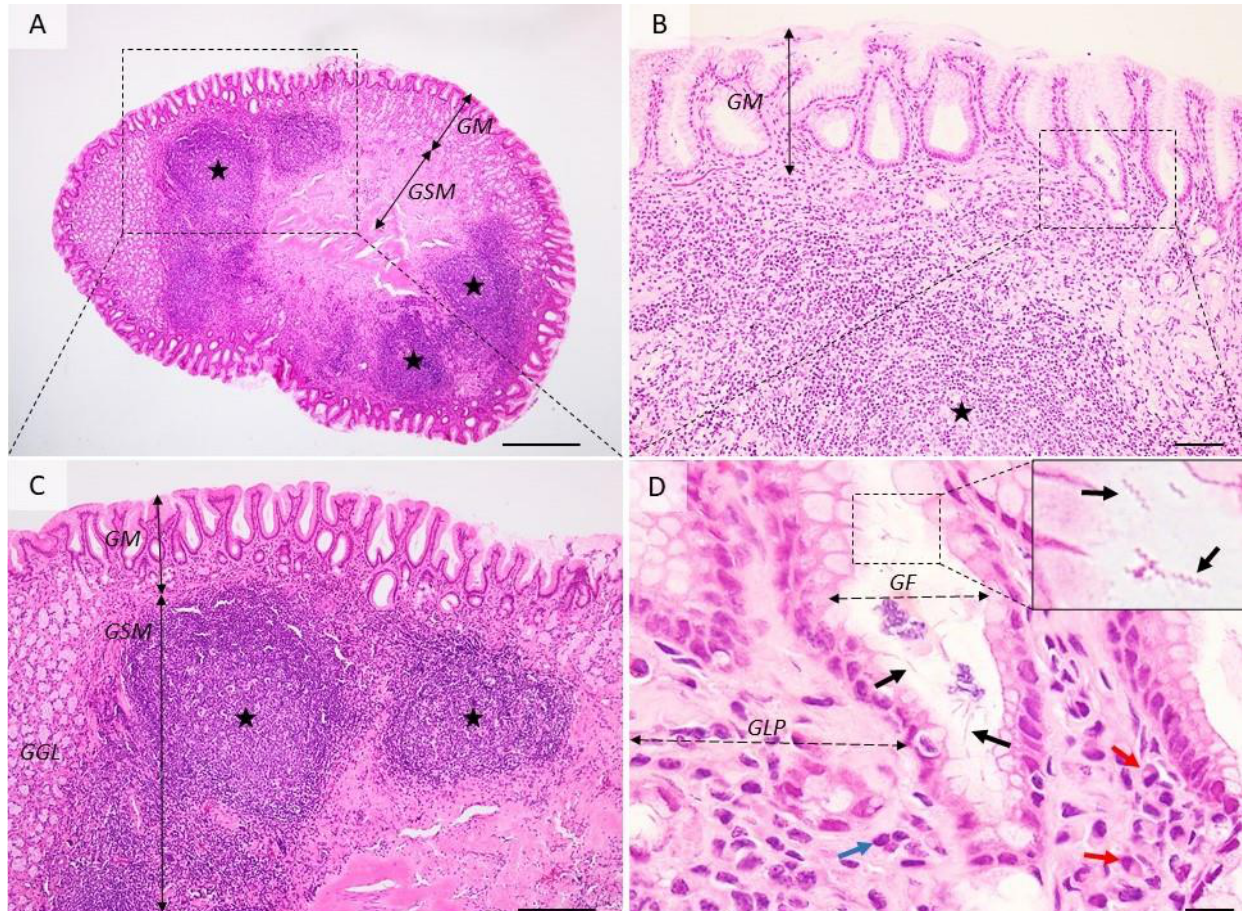
Figure 2. Histological aspects of follicular gastritis. ( A – C ) The lamina propria is multifocally distended and the gastric glands are displaced by many coalescing lymphoid follicles showing normal lymphocyte maturation. ( D ) Detailed demarcated area from ( B ). Within the gastric pits and superficial epithelium, there are many extracellular spiral-shaped bacteria measuring up to 7 µm. The lamina propria is infiltrated by many plasma cells (red arrow) and lymphocytes (blue arrow). GM = gastric mucosa; GSM = gastric submucosa; GGL = gastric glands; GF = gastric foveolar cells; GLP = gastric lamina propria; red arrows — plasma cells, blue arrow — fibroblasts, black arrows — Helicobacter spp.; black stars — lymphoid follicles. Dog, H&E stain, Ob × 4 ( A ), Ob × 20 ( B ), Ob × 10 ( C ), Ob × 100 ( D ); scale bar = 500 µm ( A ), 100 µm ( B ), 200 µm ( C ), 10 µm ( D ).